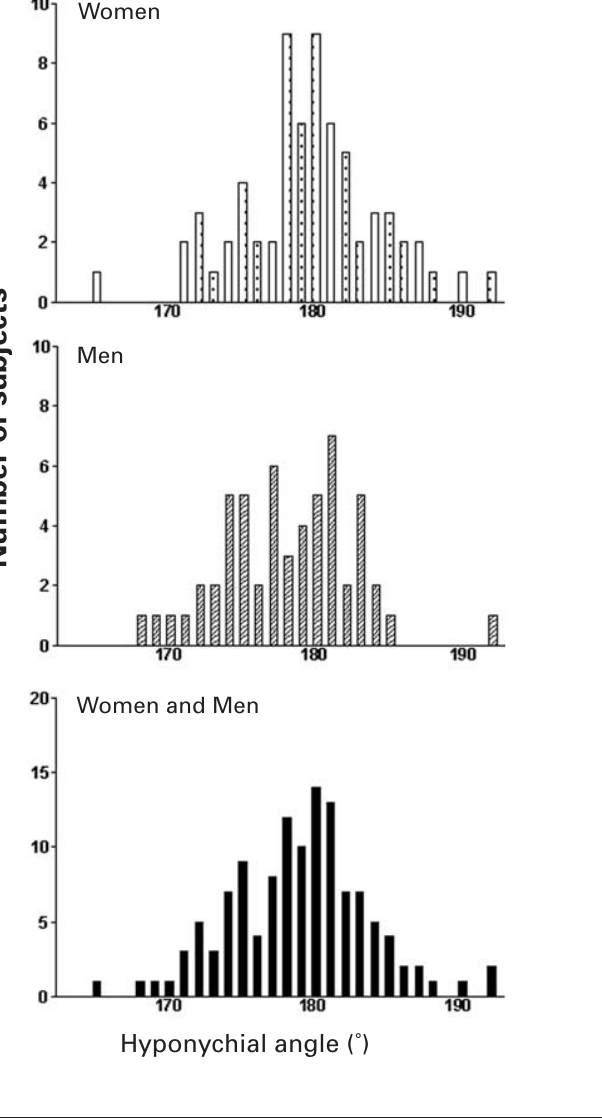
Distribution of hyponychial angles in medical inpatients. The distribution of hyponychial angles assessed by digital photography and computerised analysis is shown for female patients (upper panel), male patients (middle panel) and patients of both sexes (lower panel) respectively.